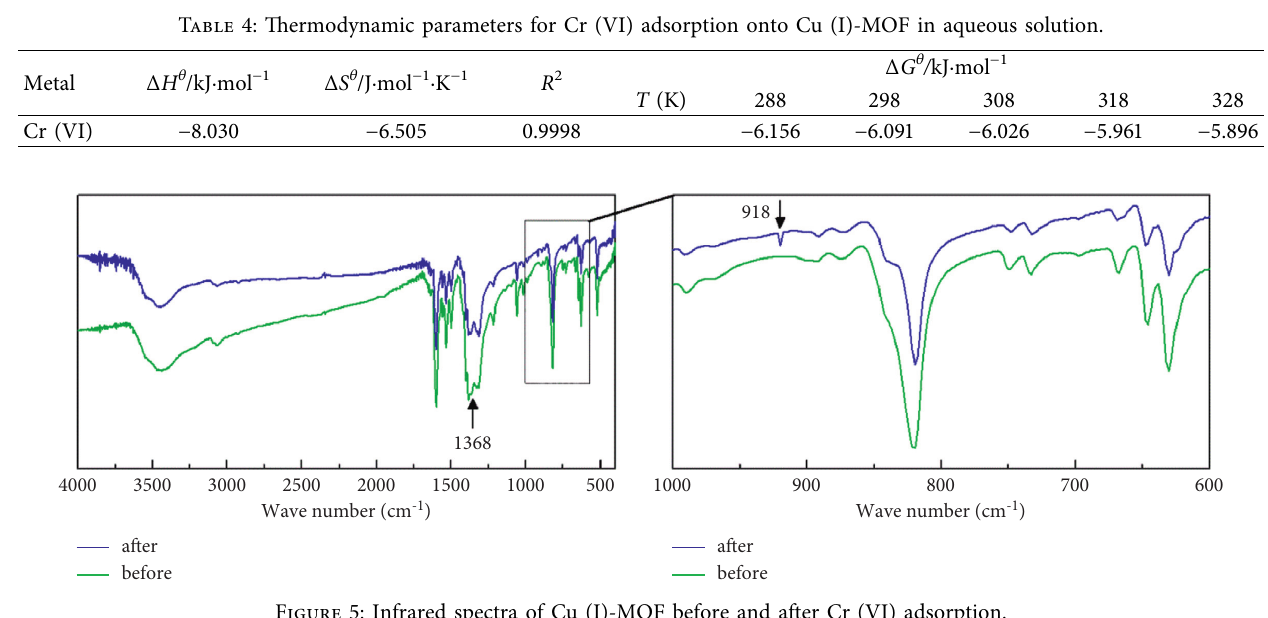
Figure 5: Infrared spectra of Cu (I)-MOF before and after Cr (VI) adsorption.